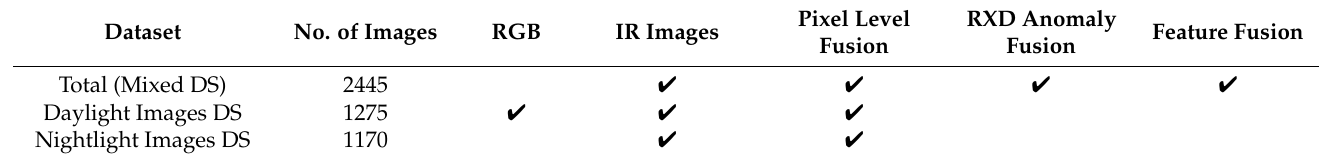
Table 1. Mixed set of images (a total of 2445 daylight and nightlight images) was created with each of the listed processes (IR, pixel-level fusion, RXD anomaly-based fusion, and feature fusion). Datasets containing only day images were separately prepared for RGB, IR, and pixel-level images. DSs containing only nightlight images were prepared for IR images and pixel-level fusion images.